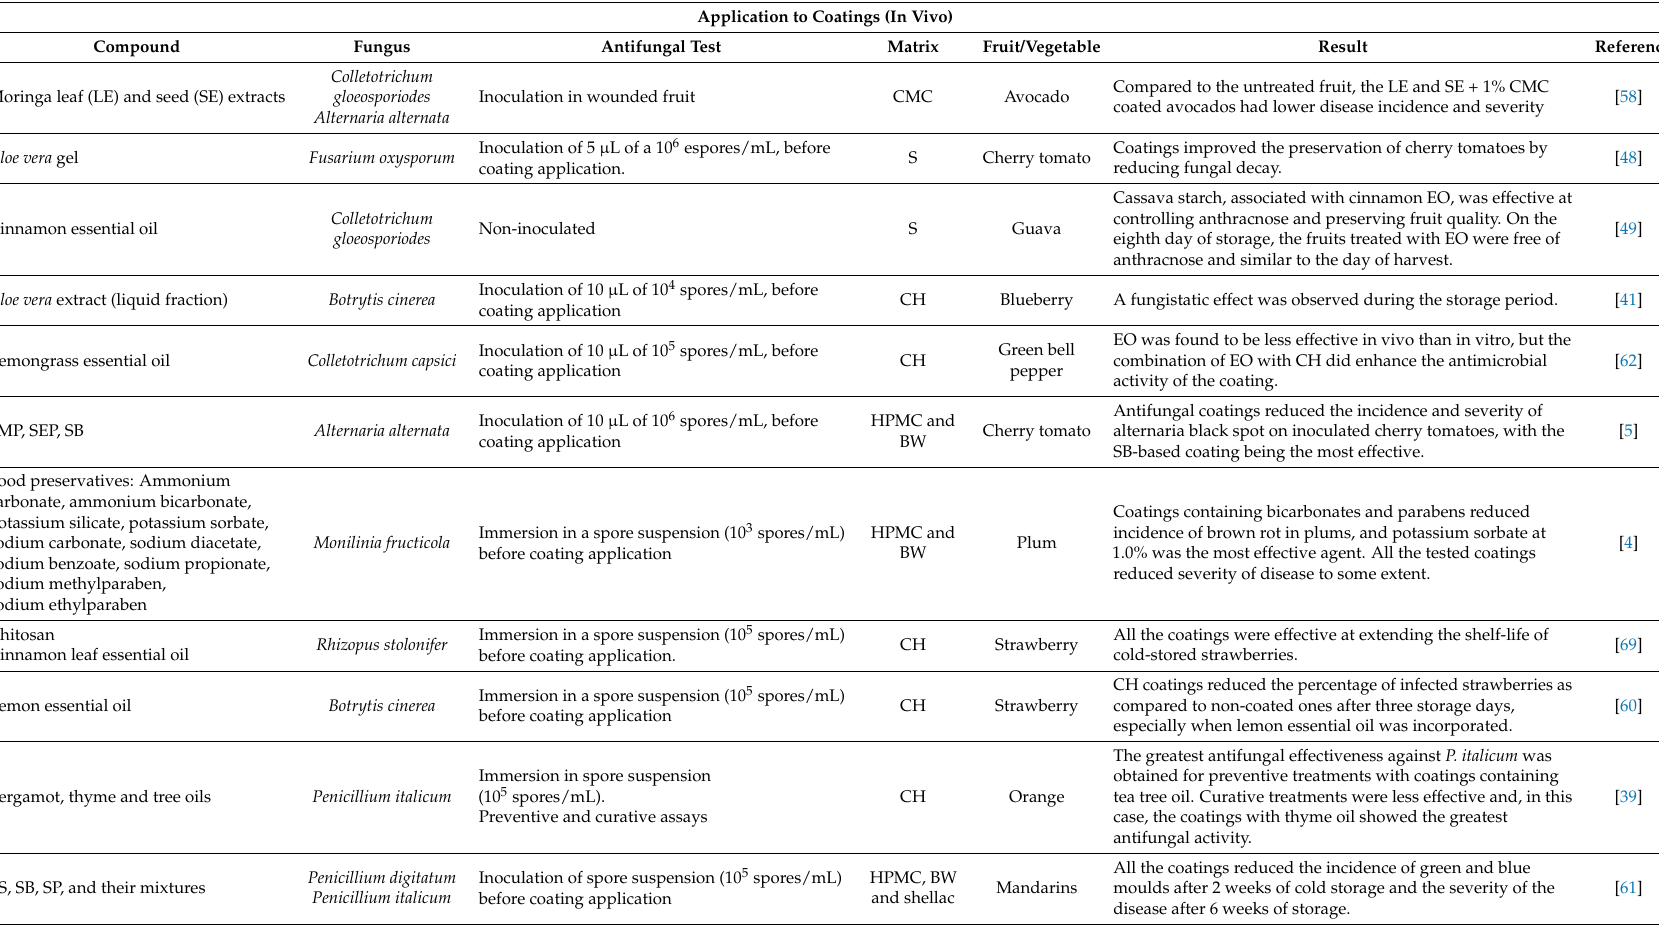
Table 6. Natural antifungal compounds applied to coatings (in vivo tests) to preserve fruits and